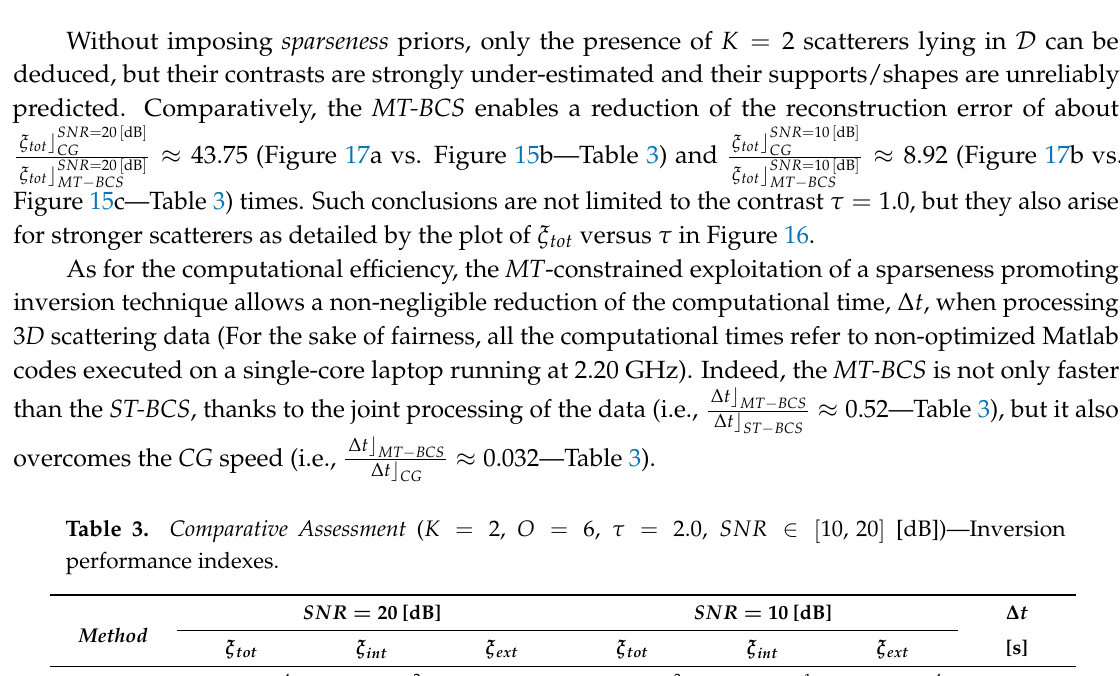
≈ 8.92 (Figure 17b vs.